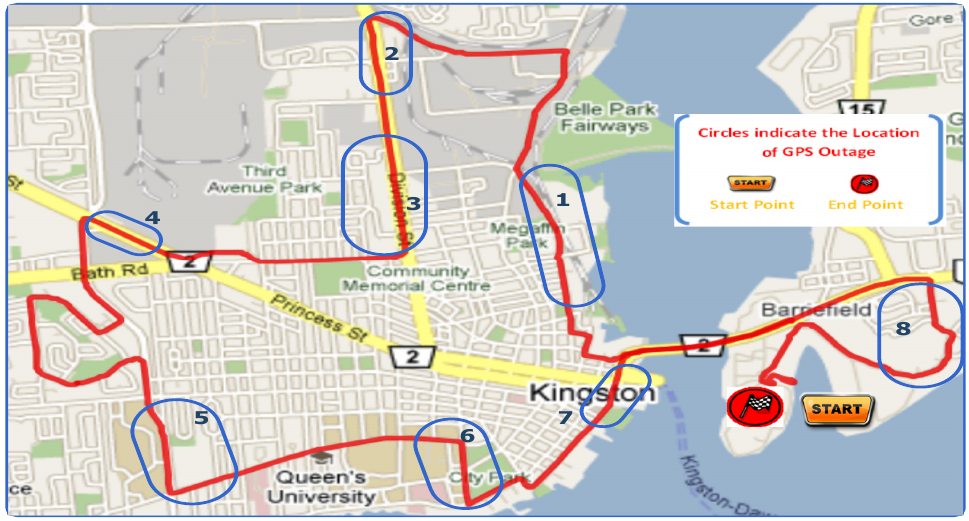
Figure 11. Road test trajectory and circles indicate the approximate locations of 120 s GNSS outages. The errors of KF-PCI and KF-only solutions were compared with respect to the NovAtel reference